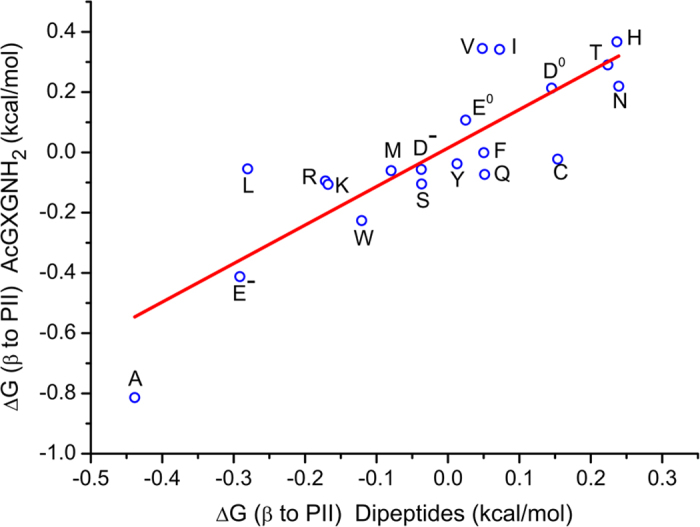
The correlation of ΔG(β to PII) derived for AcGXGNH2 and that for dipeptides.